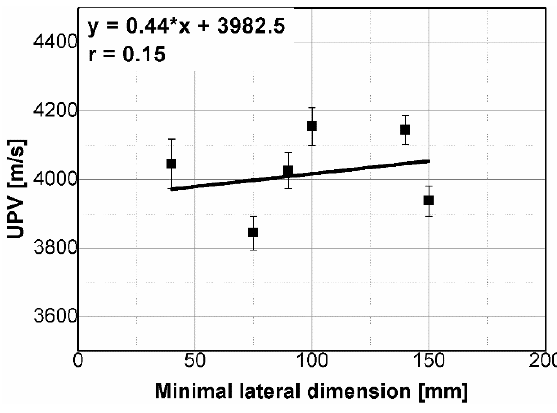
Figure 8. Pulse velocity plotted against minimal lateral dimension.